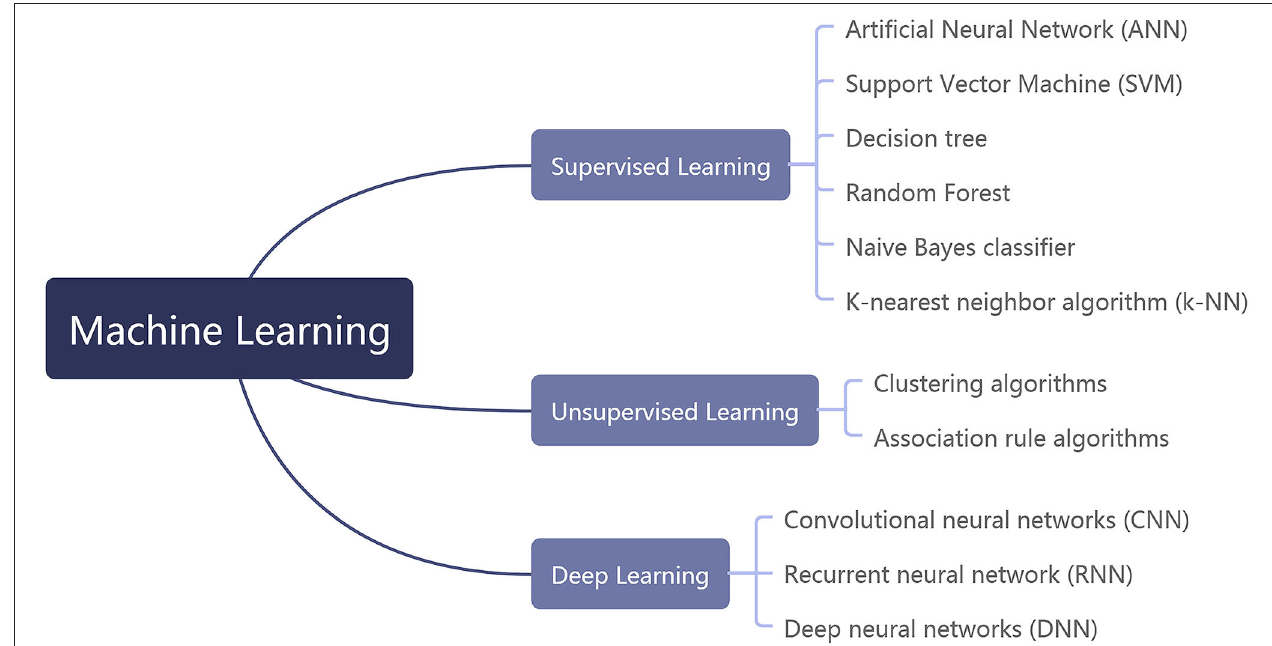
FIGURE 1 | The classification of machine